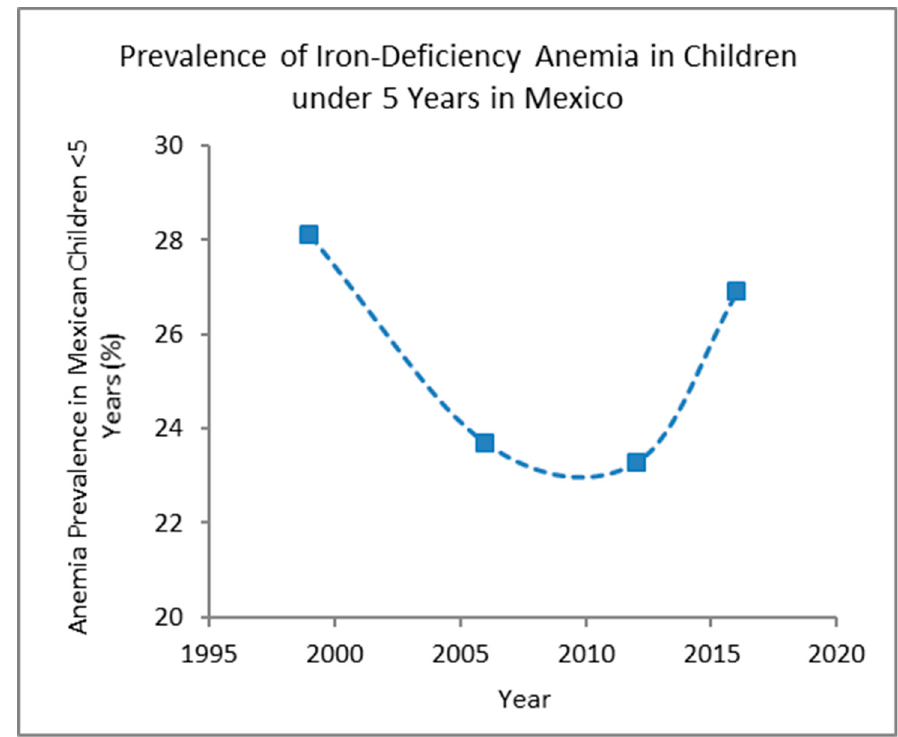
Figure 1. Prevalence of anemia in children under 5 years in Mexico (%). Data retrieved from Mexico’s national health and nutrition survey, ENSANUT (1999, 2006, 2012, and 2016)